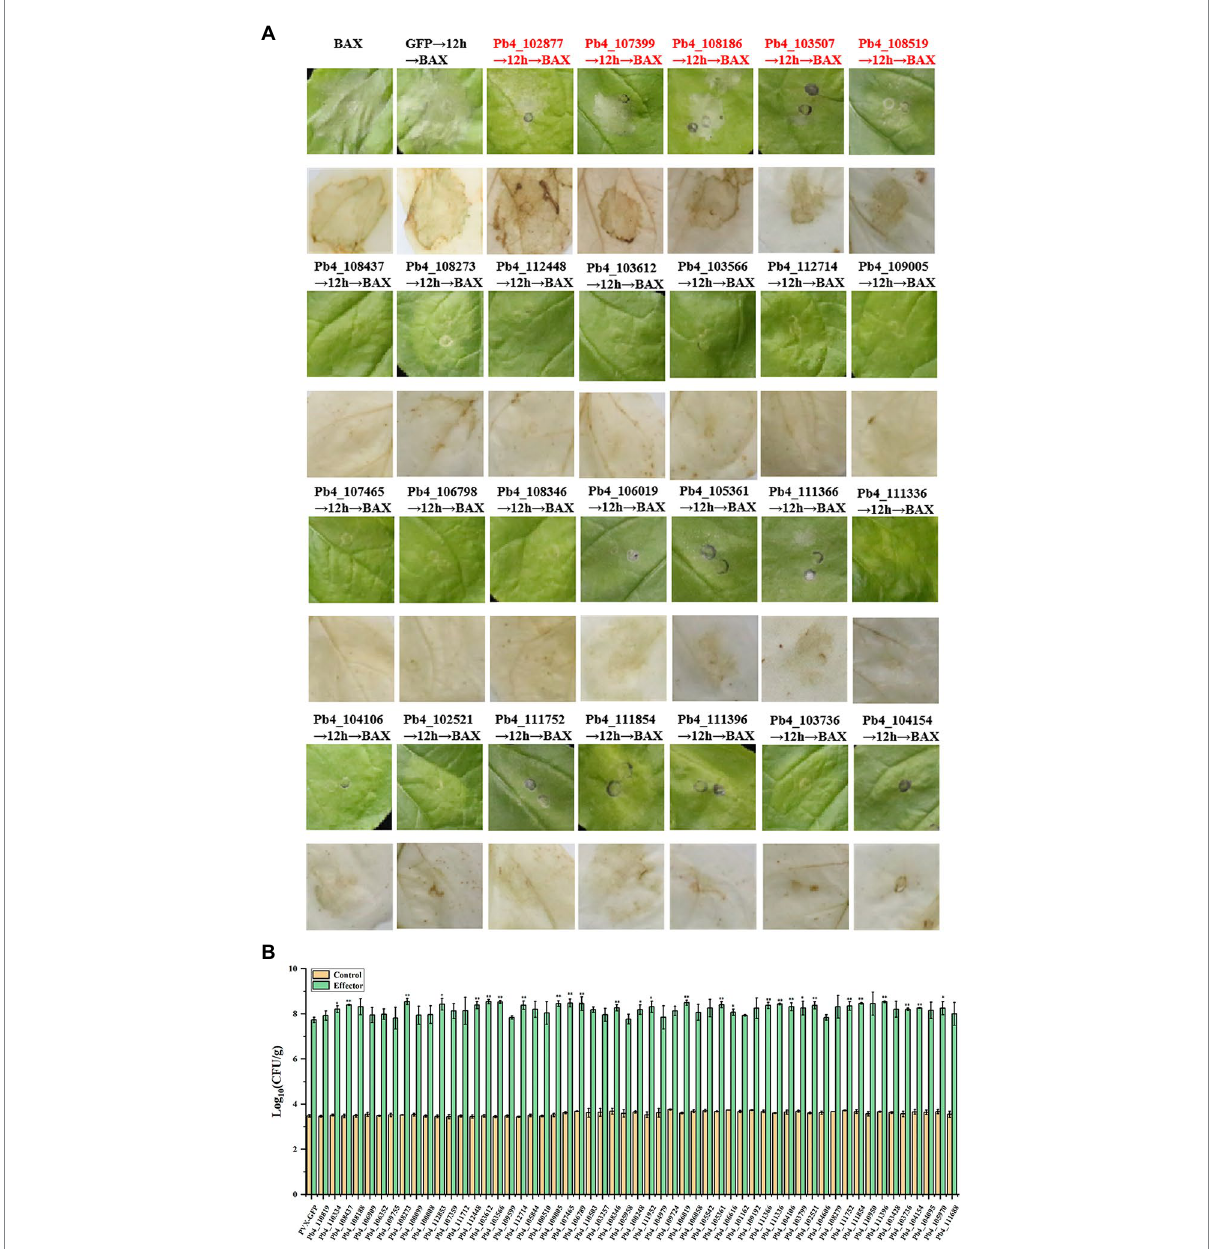
FIGURE 2 Analysis the putative effectors function in suppressing the immunoreaction in Nicothiana benthamiana and Arabidopsis. (A) Symptoms of transient expression of putative effectors in N. benthamiana leaves. The red font were the effectors which could not suppress BAX- induced cell death. The black font were the effectors significantly suppress BAX-induced cell death. HR cell death were observed four to five days after the infiltration. (B) Bacterial growth quantification of Pst DC3000 (AvrRps4) in the Arabidopsis leaves expressing the putative effector. 4-week-old plants were infiltrated with OD600 = 0.0001 after the injection of Agrobacterium tumefaciens carrying putative effector genes or GFP as control and the samples were collected at 0 (yellow bars) and 3 dpi (green bars) for assay. Error bars represent SD of the mean of six samples. Significance difference between treatment and control groups ( t -test): * p < 0.05; ** p <